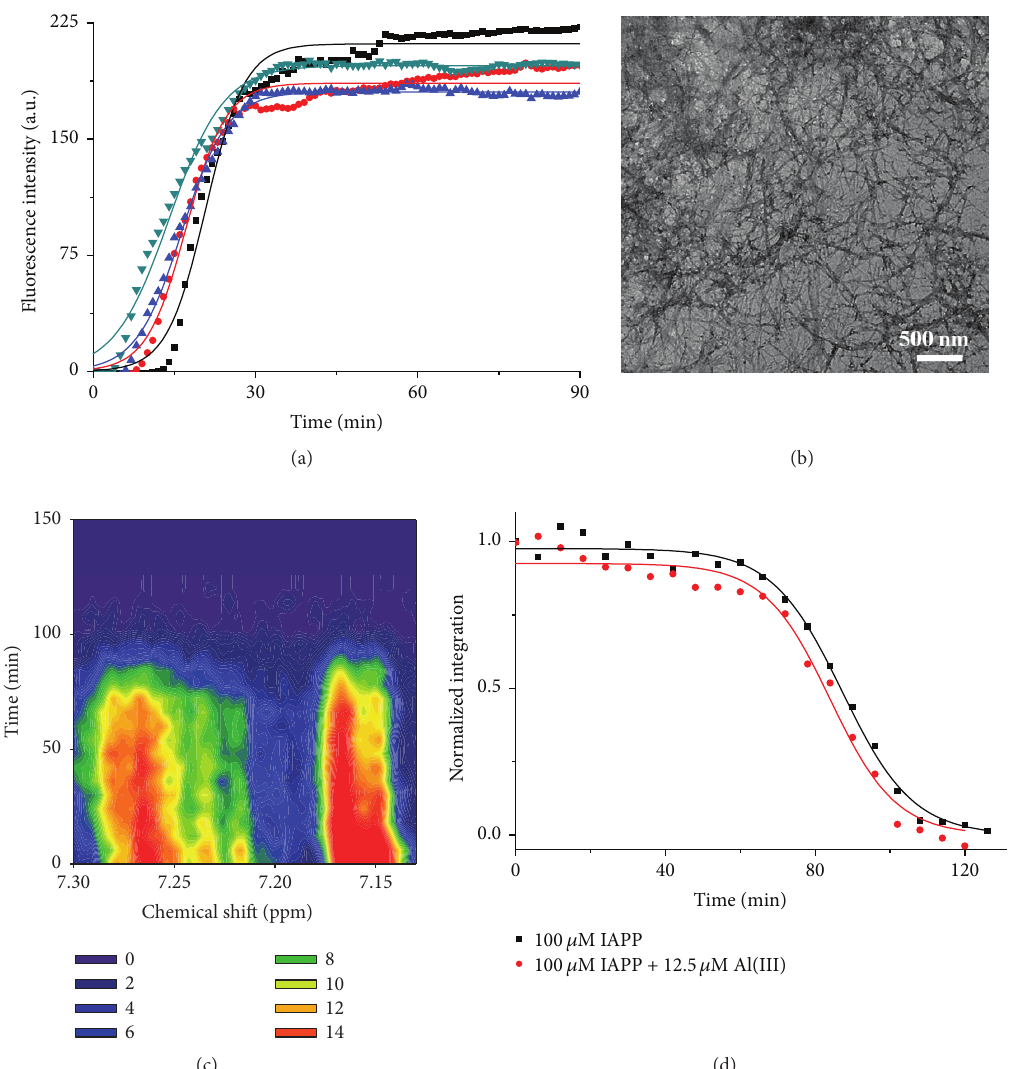
Figure 5: The influenceof Al(III) on the fibrillation and aggregation of hIAPP. (a) Kinetics of 16 𝜇 M hIAPP fibrillation with 0 ( ◼ ), 2 ( e ), 8 ( 󳵳 ), and 64 ( 󳶃 ) 𝜇 M Al(III) in 20mM PBS at pH 7.4 under 37 ∘ C, monitored by ThT fluorescence. The values represent mean ( 𝑛 = 3 ). Solid lines represent the curves fitted using (1). (b) TEM image of 16 𝜇 M hIAPP incubated in 20mM PBS with 2 𝜇 M Al(III) for 2h. (c) Contour plots of 1 H NMR spectra within chemical shift from 7.13 to 7.3ppm for 100 𝜇 M hIAPP incubated in 6mM PBS at pH 7.4 and 25 ∘ C on incubation time with 12.5 𝜇 M Al(III). (d) Aggregation kinetics of integrated resonance intensity of 1 H NMR spectra from 7.13 to 7.3 ppm of 100 𝜇 M hIAPP without ( ◼ ) and with ( e ) 12.5 𝜇 M Al(III). Solid lines representthe curves fitted using (1). The integration values were normalized to the initial hIAPP alone